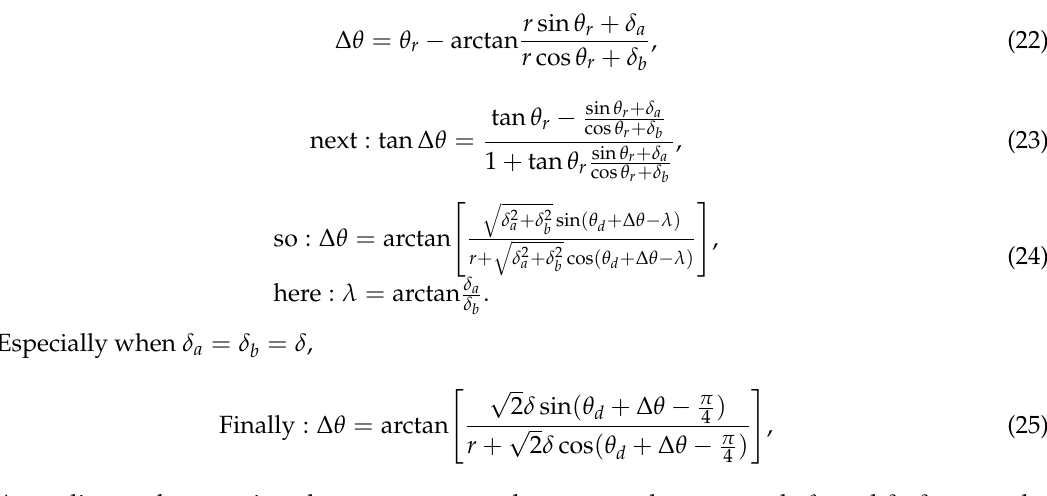
Figure 4. Distribution law of N